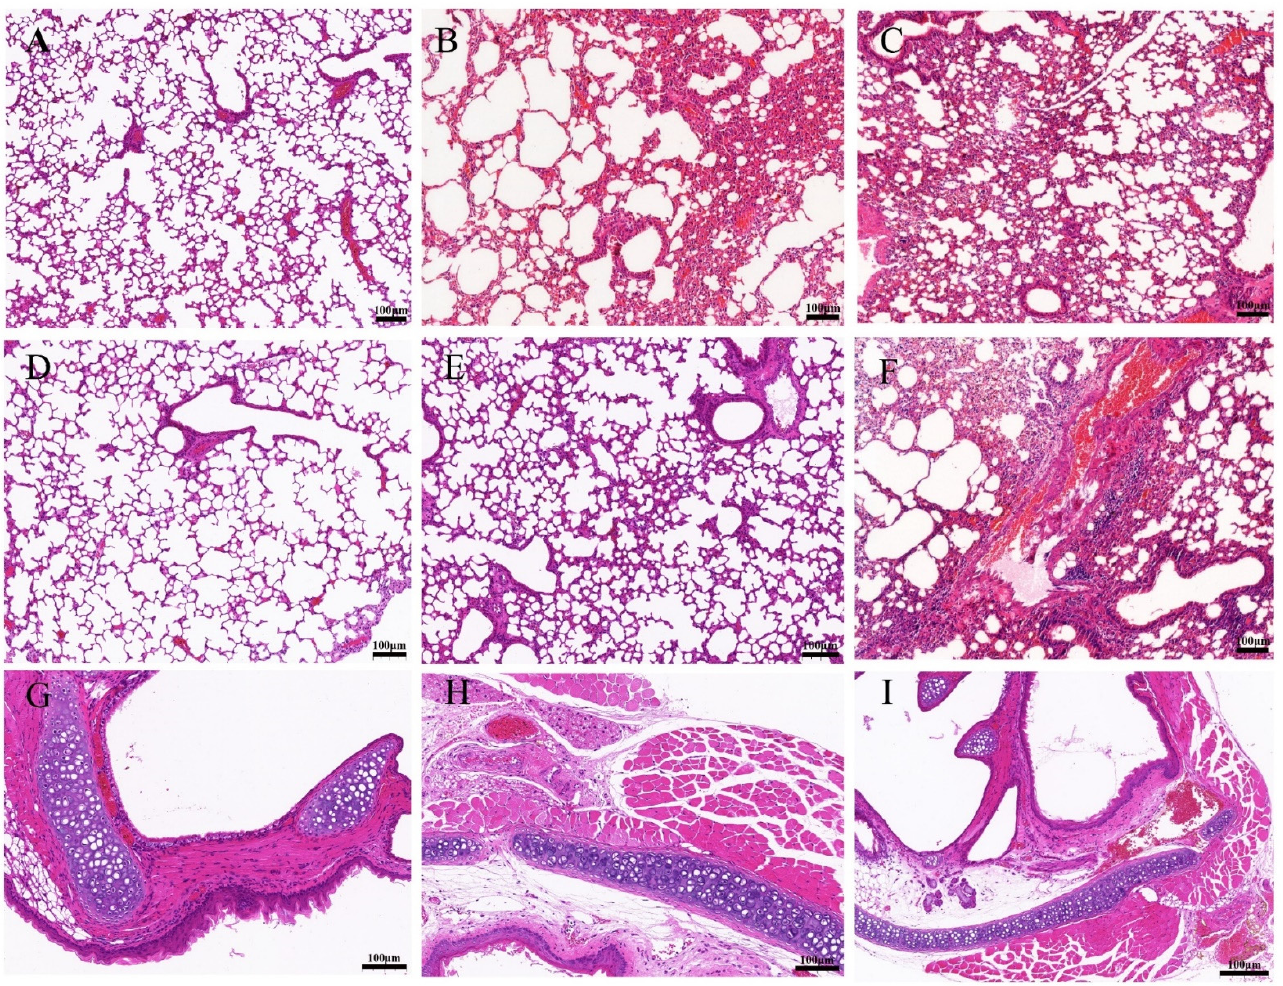
Figure 7. Histopathologic examination of lung and trachea lesions in mice at sixth day post-challenge of H3N2 (CVCC AV1520). ( A – F ): Lung changes of different groups. ( A ): NC (lung); ( B ): inactivated vaccine (IIV) group; ( C ): BNV group; ( D ): BNV + MF59 group; ( E ): BNV + CPG group; ( F ): PBS control group; ( G – I ): trachea changes of different groups; ( G ): NC (trachea); ( H ): inactivated vaccine (IIV) group; ( I ): BNV group (Scale bar = 100 µm). All specimens were processed according to